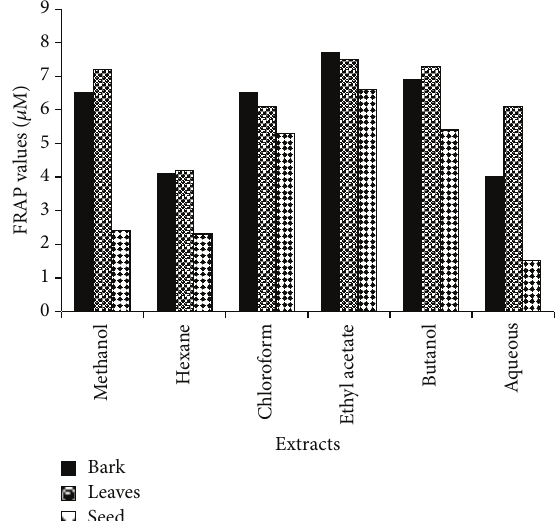
Figure 2: IC 50 𝜇 g values of different extracts of L. pulverulentus .